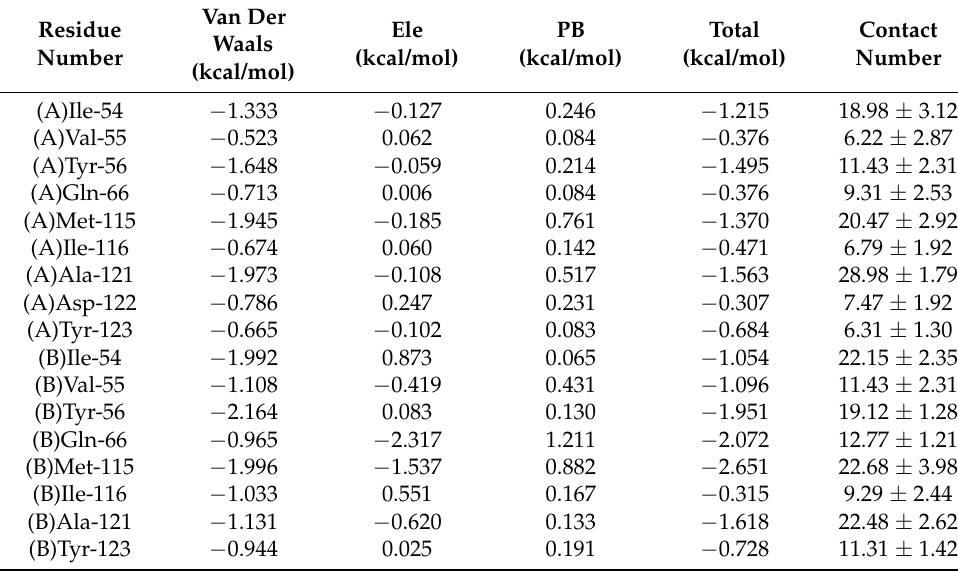
Table 3. Capsaicin system per-residue energy